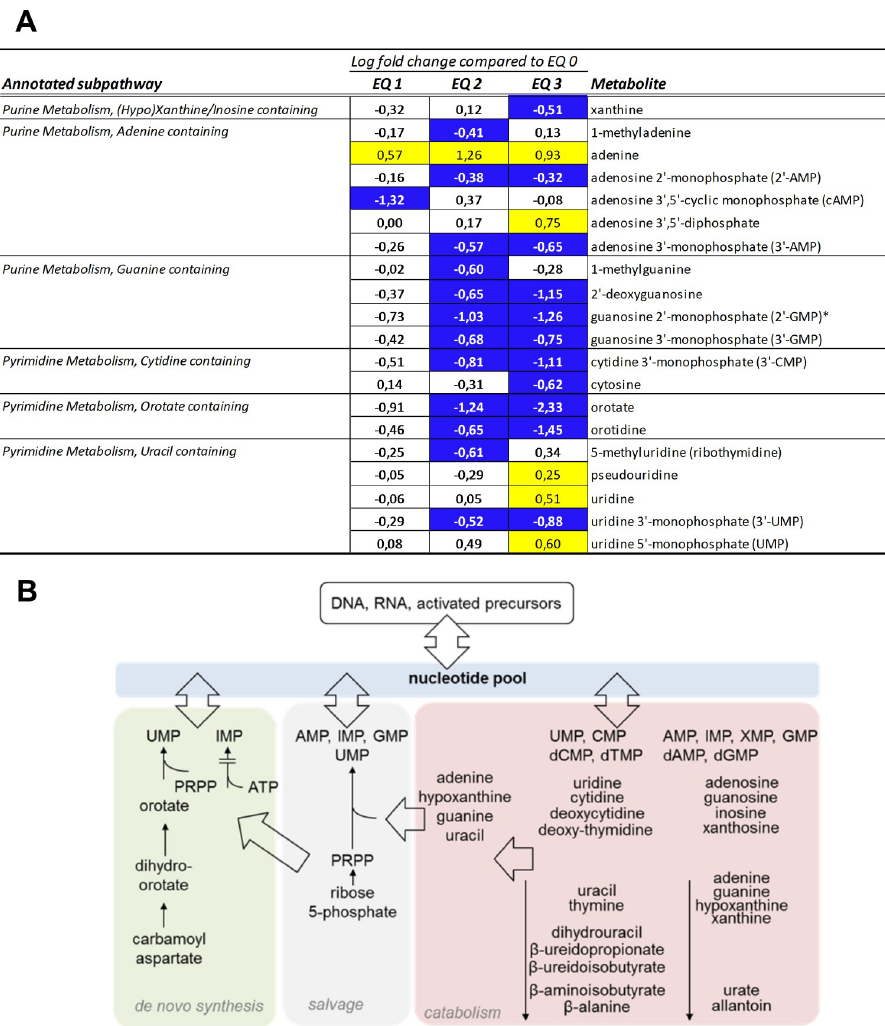
Fig 5. Alterations in purine and pyrimidine metabolism in livers of Atlantic salmon ( Salmo salar L.) exposed to graded levels of ethoxyquin (EQ) through their diet for 90 days. (A) Metabolites displaying differential expression ( p < 0.05, ANOVA) were grouped according to subpathway annotations. Scaled intensity means were used to calculate log2 fold changes in the individual exposure groups compared to unexposed control animals (EQ 0). Significance of change was analyzed through pairwise comparisons between the individual exposure groups and the control, with colors denoting a significantly ( p < 0.05) increased (yellow) or decreased (blue) levels compared to the control. See S4 Table for a complete overview of individual metabolites. (B) Overview of nucleotide metabolites within the pathways of nucleotide synthesis, salvage, and catabolism.